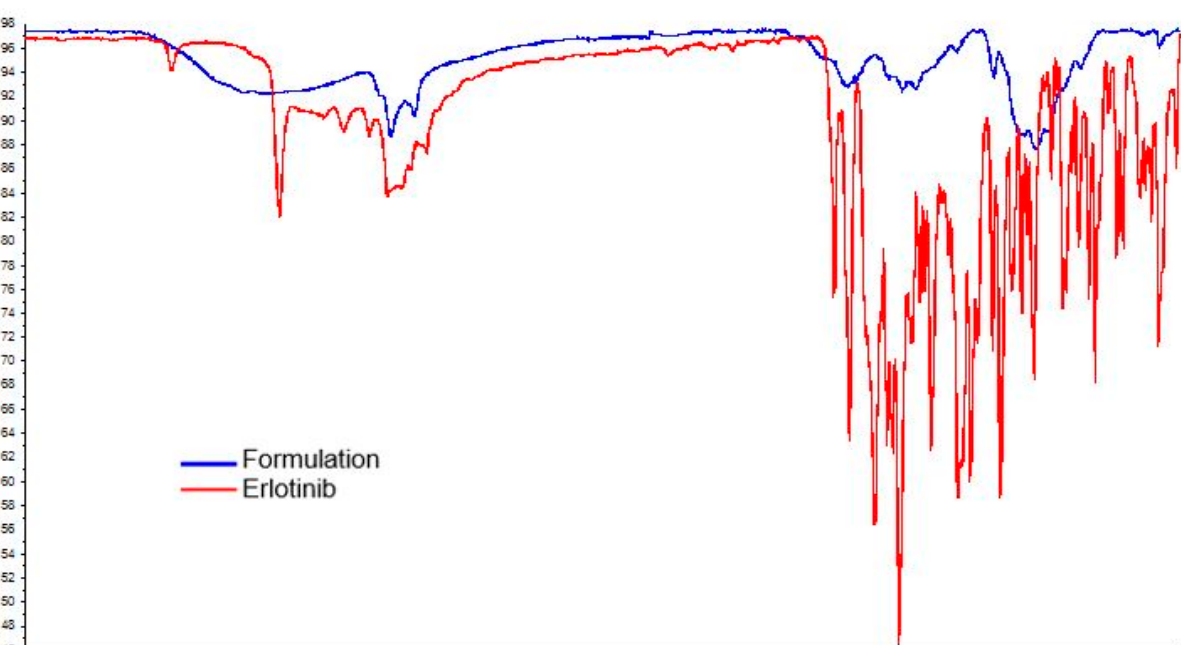
Figure A6. Erlotinib infrared spectra and formulation overlapping.